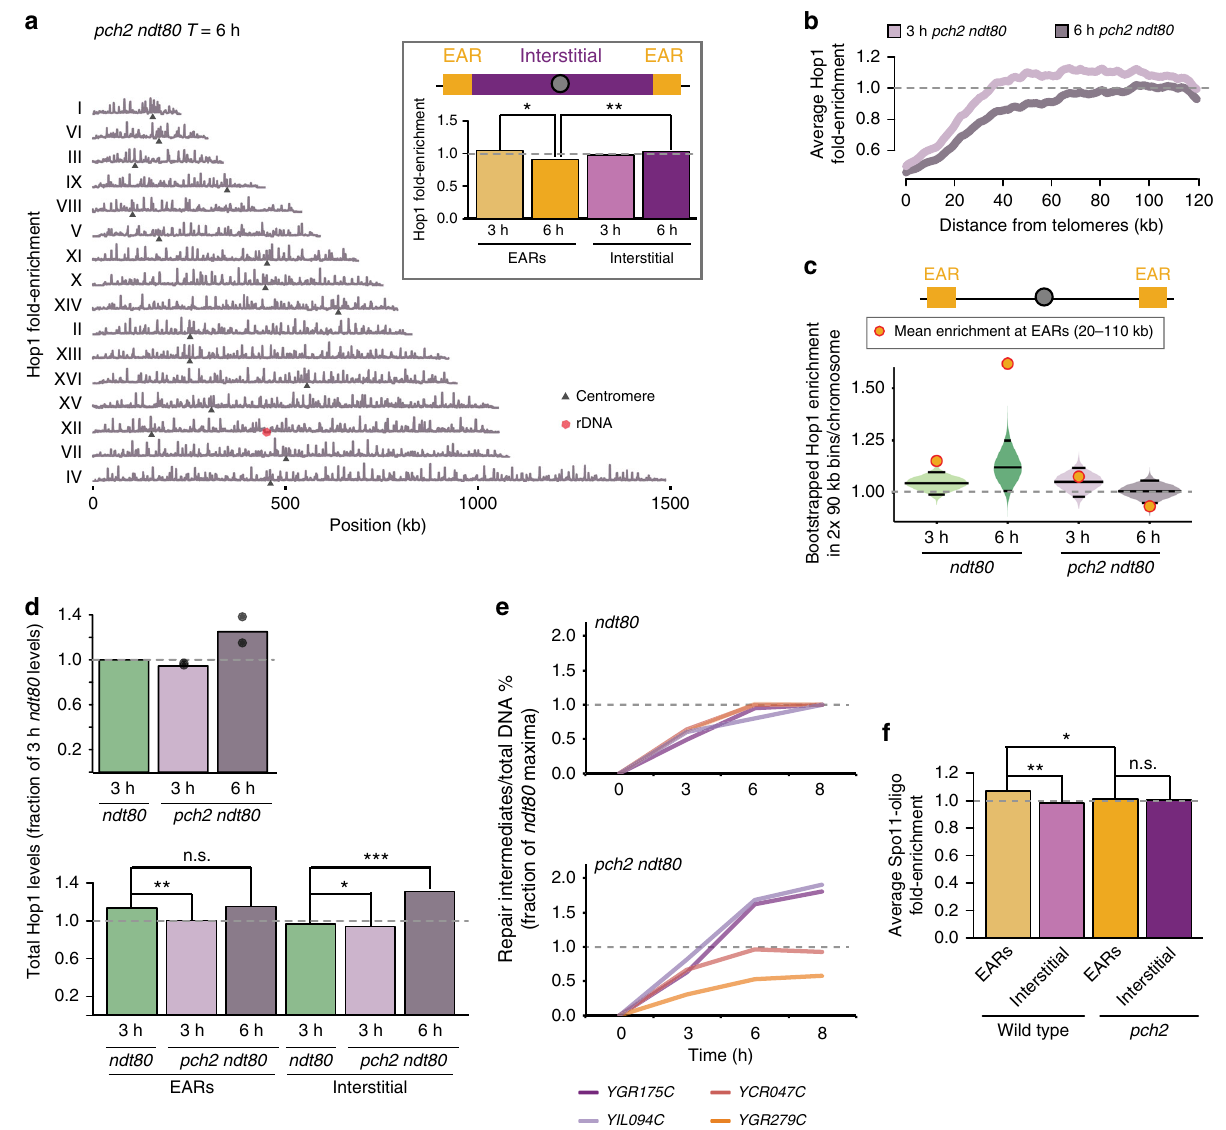
Fig. 4 Pch2 controls regional distribution of Hop1 and DSBs in EARs. a Hop1 ChIP-seq enrichment in pch2 Δ ndt80 Δ late prophase ( T = 6 h) cells plotted along each of the 16 yeast chromosomes; black triangles mark the centromeres and the red hexagon marks the rDNA locus. The data are normalized to a global mean of 1. Inset shows mean Hop1 enrichment in EARs (20 – 110 kb, orange) and interstitial chromosomal regions (magenta) in early prophase ( T = 3 h) and late prophase ( T = 6 h). ** P < 0.01 and * P < 0.05, Mann-Whitney-Wilcoxon test. b Mean Hop1 enrichment in the EARs (32 domains) is plotted as a function of the distance from telomeres in pch2 Δ ndt80 Δ at early ( T = 3 h) and late prophase ( T = 6 h). The gray dashed line is genome average. c Bootstrap-derived distributions within two 90-kb bins per chromosome from Hop1 ChIP-seq data illustrated as violin plots for ndt80 Δ and pch2 Δ ndt80 Δ cells. The horizontal lines in the violin plots represent the median and the two-ended 95% CIs. The mean Hop1 ChIP-seq enrichment in EARs (20 – 110 kb) for the respective samples is shown as orange/red dots. The gray dashed line is genome average. d Spike-in normalized Hop1 enrichment in pch2 Δ ndt80 Δ at T = 3 h and T = 6 h compared to early prophase ( T = 3 h) ndt80 Δ sample. Total Hop1 levels are depicted in the upper panel. The range in levels is depicted with black dots. The lower panel shows spike-in normalized Hop1 levels from early prophase ( T = 3 h) and late prophase ( T = 6 h) pch2 Δ ndt80 Δ samples plotted as mean enrichment in EARs (20 – 110 kb) and interstitial chromosomal regions compared to early prophase ndt80 Δ sample. The gray dashed line is genome average of early prophase ndt80 Δ sample. *** P < 0.0001, ** P < 0. 01, * P < 0.05, and n.s. P = 0.32, Mann-Whitney-Wilcoxon test. e Cumulative DNA breaks measured as percentage of repair intermediates over total DNA and depicted as a fraction of ndt80 Δ at T = 8 h are shown for ndt80 Δ , and pch2 Δ ndt80 Δ . Interstitial hotspots ( YGR175C , YIL094C ) are shown in shades of magenta and hotspots in EARs ( YCR047C , YGR279C) are depicted in shades of orange. The data are averages of two independent biological replicates. f Spo11-oligo signals from wild-type control 44 and pch2 Δ mutant are normalized to genome average and plotted as mean signal in EARs (20 – 110 kb, 32 domains) and interstitial chromosomal regions (>110 kb from either end of all chromosomes, 16 domains). The gray dashed line is the genome average. ** P < 0.01, * P < 0.1, n.s. not signi fi cant, ANOVA on